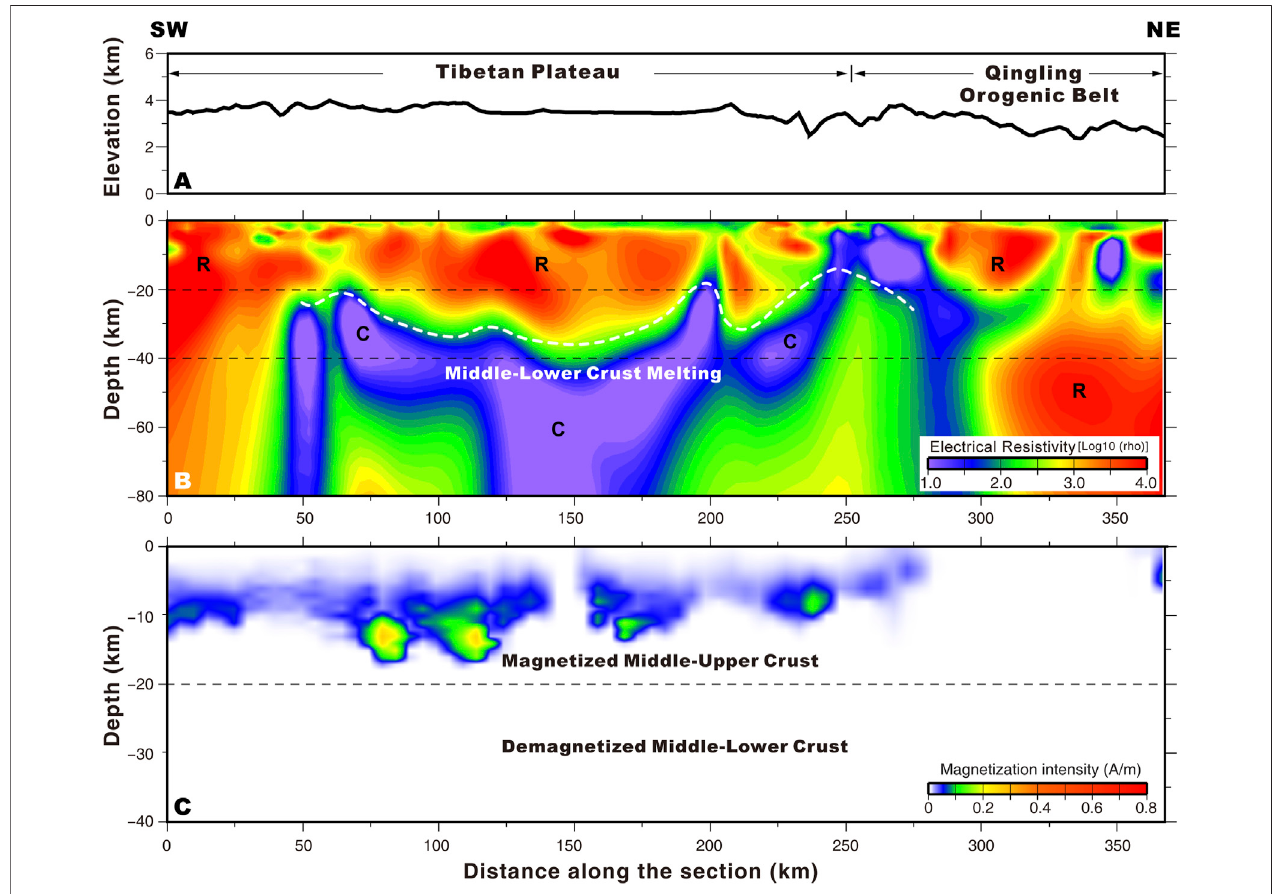
FIGURE 8 | Line three magnetotelluric survey magnetization distribution pro fi le: (A) altitude (B) electrical resistivity and (C) magnetization distribution.